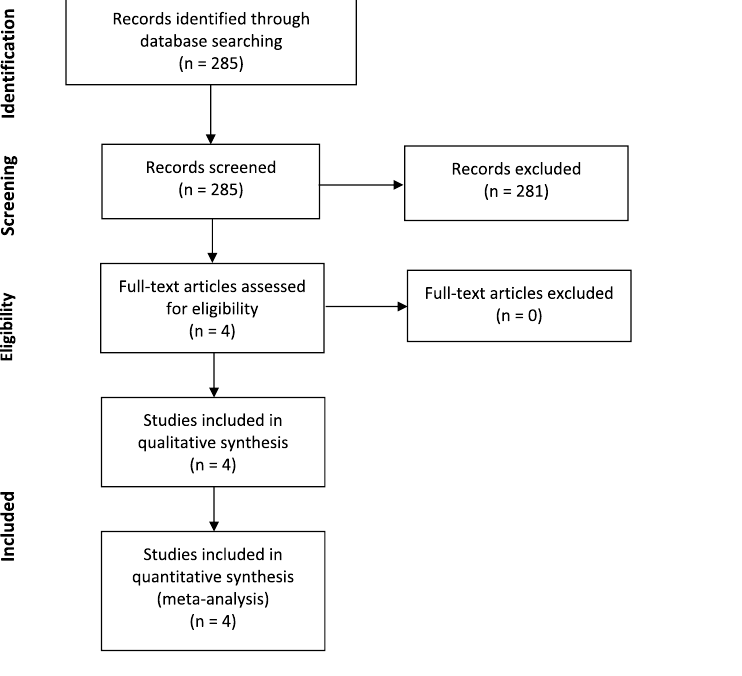
Figure 1. PRISMA